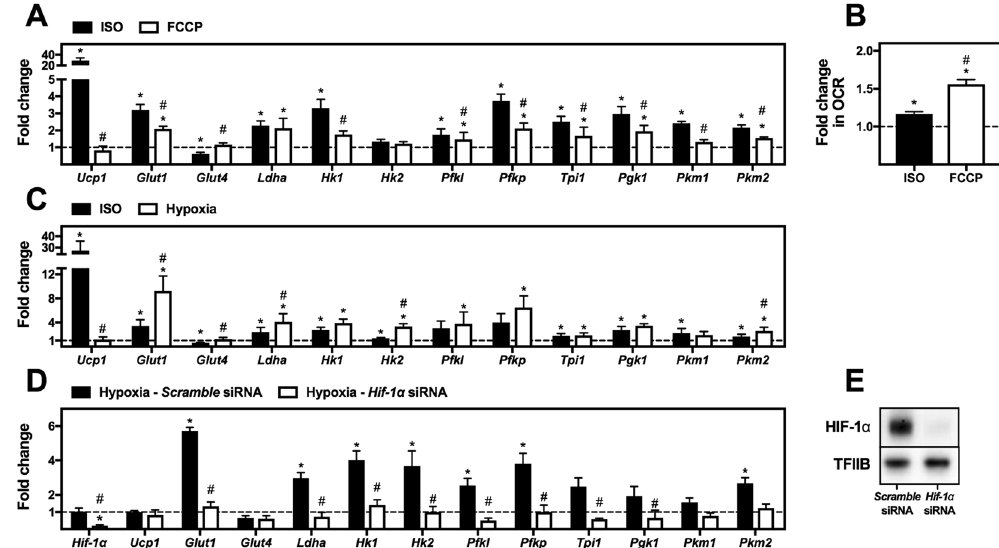
Figure 3. Expression levels of genes associated with glycolysis during chemical uncoupling or hypoxia. ( A ) Total RNA was isolated from mature brown adipocytes (WT-1) treated with vehicle, 0.1 μ M isoproterenol (ISO) (black bars) or 1 μ M of the chemical uncoupler FCCP (white bars) for 12 h. Relative gene expression was analyzed by RT-qPCR (n = 4) and presented as fold change relative to the corresponding vehicle-treated samples. ( B ) Representative fold induction in oxygen consumption rate (OCR) 30 min after stimulation of WT-1 brown adipocytes with 0.1 μ M ISO (black bar) or 1 μ M FCCP (white bar) on a Seahorse XF96 Flux Analyzer (n = 3) ( C ) Total RNA was isolated from mature brown adipocytes (WT-1) treated with vehicle or 0.1 μ M ISO (black bars) or exposed to hypoxia (1% O 2 ) (white bars) for 12 h. Relative gene expression was analyzed by RT-qPCR (n = 5) and presented as fold change relative to the corresponding control samples. ( D ) Total RNA was isolated from mature brown adipocytes (WT-1), which were reverse transfected with scramble siRNA or siRNA against Hif-1 α at day 6 after initiation of differentiation. Mature cells at day 10 were exposed to normoxia or hypoxia (1% O 2 ) for 12 h. Relative gene expression was analyzed by RT-qPCR (n = 3) and presented as fold change relative to the corresponding normoxia control samples. ( E ) Immunoblotting analyses of HIF-1 α in brown WT-1 adipocytes transfected with scramble siRNA or siRNA against Hif-1 α . The mRNA expression levels were normalized to Tbp . Gene expression data represent mean of means + SEM. * p < 0.05 versus vehicle control. # p < 0.05 versus ISO stimulated cells (panel A and C) or scramble siRNA transfected cells (panel D). Transcription factor II B (TFIIB) was used as loading control in panel E. Full-length blots for panel E are shown in Supplementary Figure